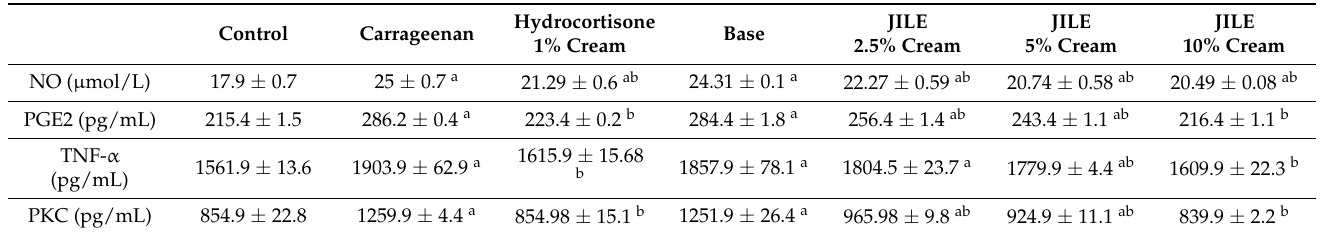
Table 2. Effect of topical administration of ethanol extract of Jatropha integerrima cream on different inflammation